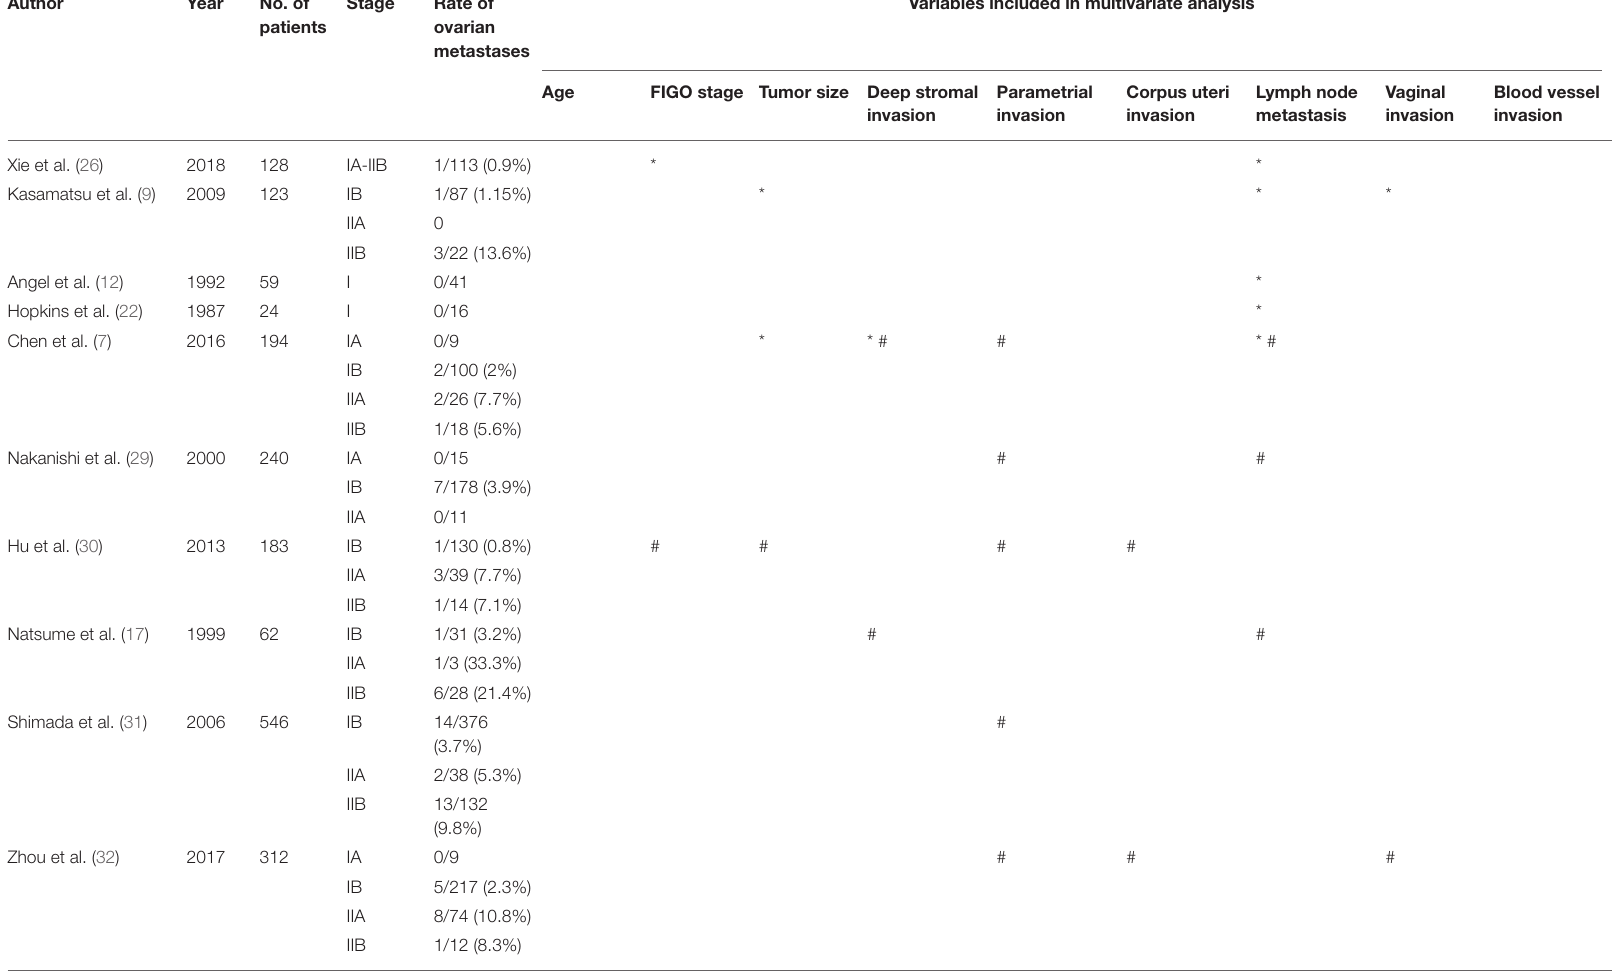
TABLE 2 | Overview of prognostic factors for cervical adenocarcinoma and risk factors for ovarian metastases reported in the studies.